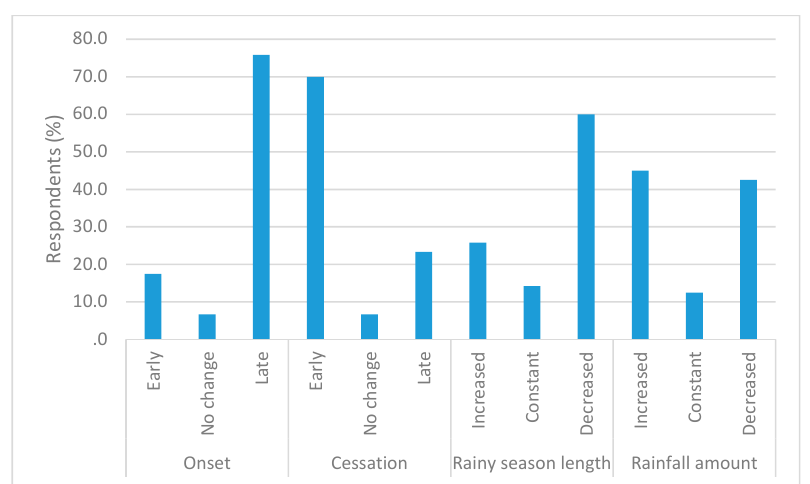
Figure 3. Farmers’ perception of changes in rainfall patterns.